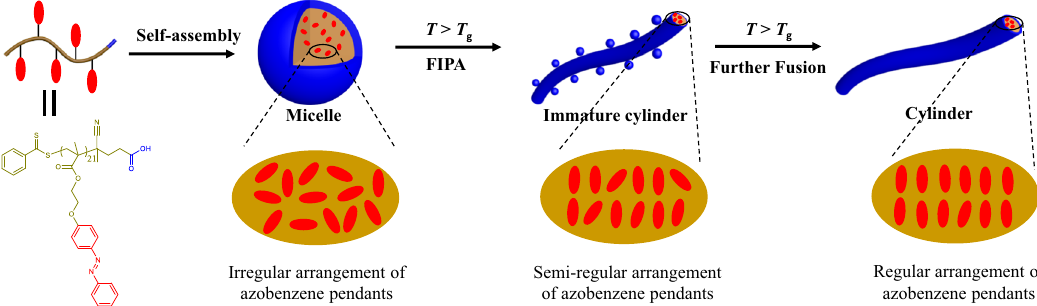
Fig. 3 Proposed mechanism of the transformation from amorphous micelles to crystalline cylinders during CD-FIPA. The azobenzene pendants arrange randomly in the amorphous micelles. When incubated at 75 °C (higher than the T g of PAzoMA), the chain mobility of PAzoMA signi fi cantly increases, leading to the regular arrangement of azobenzene pendants and crystalline structure of